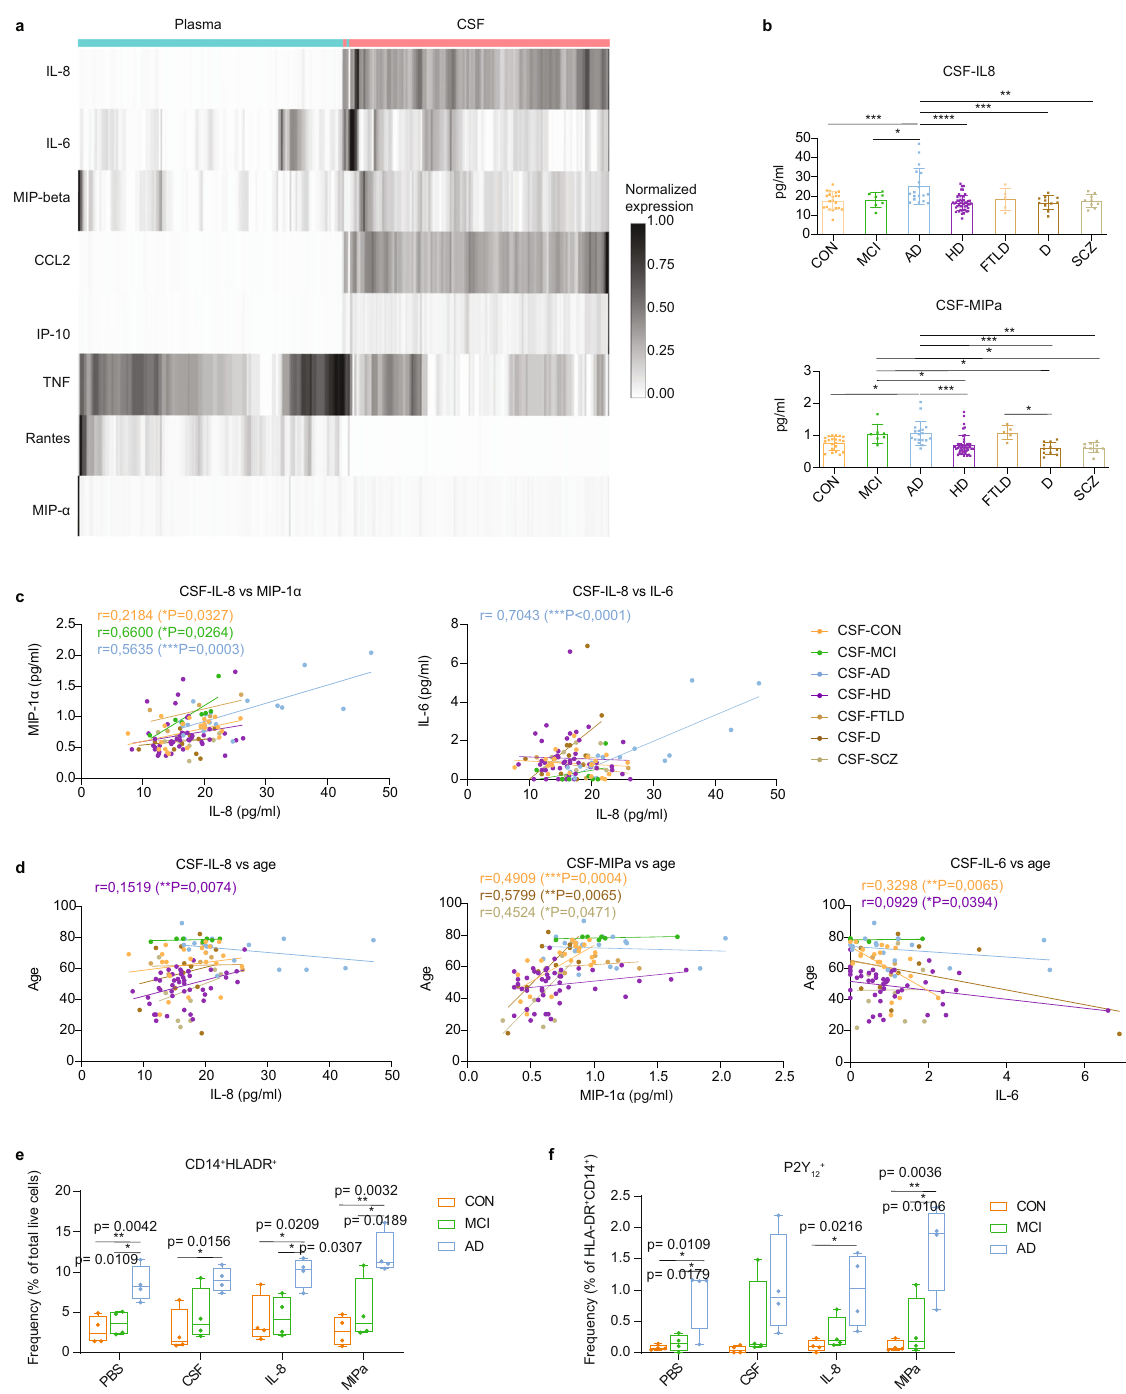
Fig. 4 | Differential concentration of in fl ammatory mediators between plasma ( n =117, biological replication) and CSF ( n =117, biological replication) deter- mined using Luminex protein array. These are CON individuals ( n =21) and patients with MCI ( n =7), AD ( n =18), HD ( n =46), depression ( n =11), FTLD ( n =5) and SCZ ( n =9) individuals. a Heatmapshowed the expressionofIL-8,IL-6, MIP-1 β , CCL2,IP-10,TNF,Rantes(CCL5)andMIP-1 α thatwerequanti fi edinplasmaandCSF. b Bar graphs showdifferential concentrations (pg/ml)of IL-8 and MIP- α in the CSF ofpatientswithAD,comparedtoCONindividualsandpatientswithotherdiseases. Each dot represents the value of each sample. Data displayed as mean±SD. One- way ANOVA with the Tukey ’ s multiple comparisons; * p <0.05, ** p <0.01 and *** p <0.001. c Scatter plots showing correlation between mean CSF-concentration of IL-8 and MIP- α or IL-6 of all groups. * P <0.05, ** P <0.01 and *** p <0.001, non- parametric Spearman correlation test (r), two-sided. d Scatter plots showing